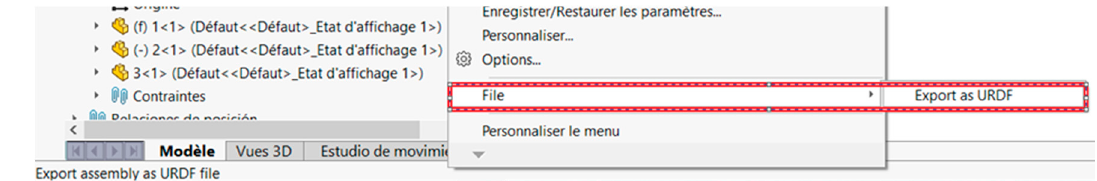
Figure 7. Simscape Multibody Link in SolidWorks.